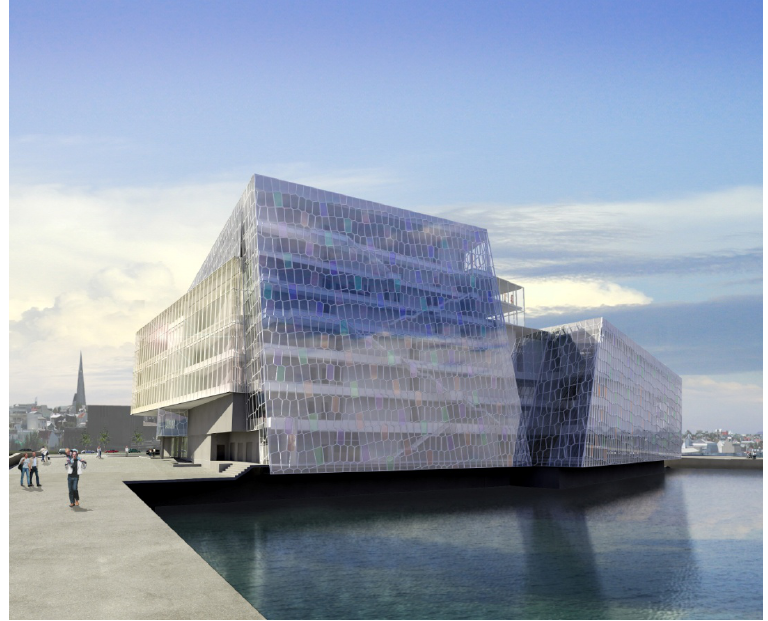
Figure 2. Rendering of north elevation, Reykjavik New Concert Hall,